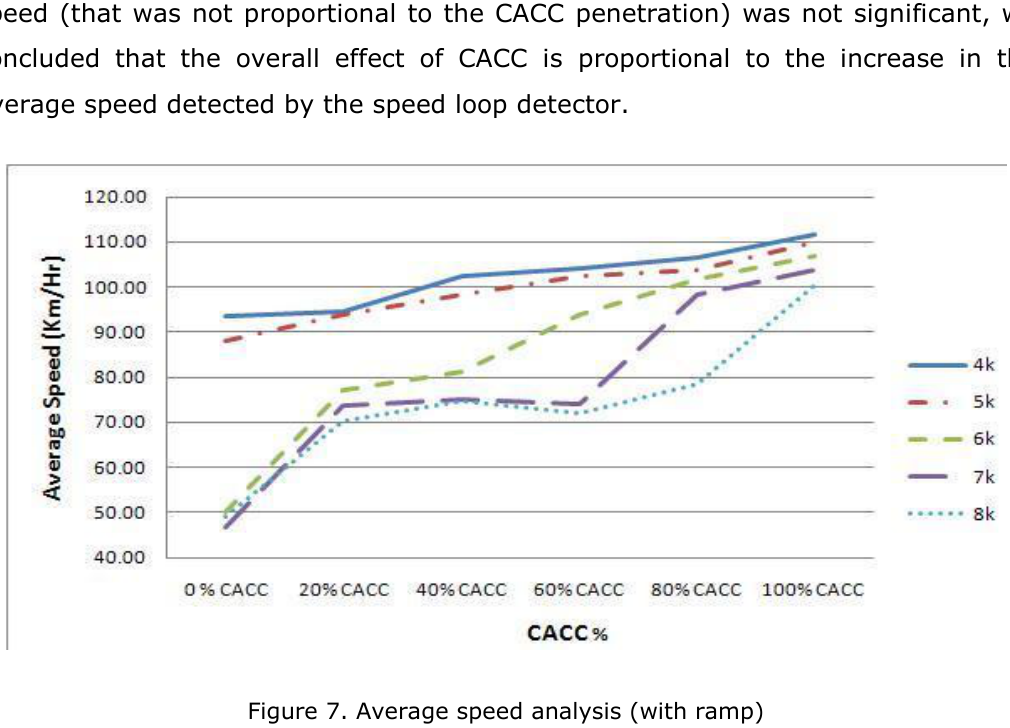
Equation 1. Forecasted model equation